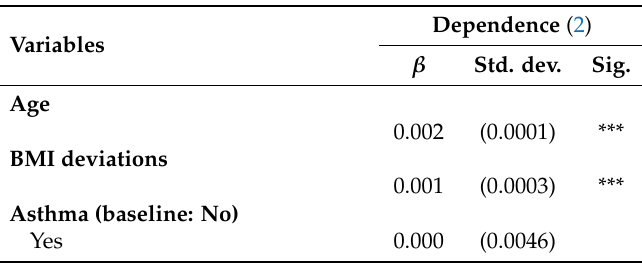
Table 7. Results for the regression model for dependence (model